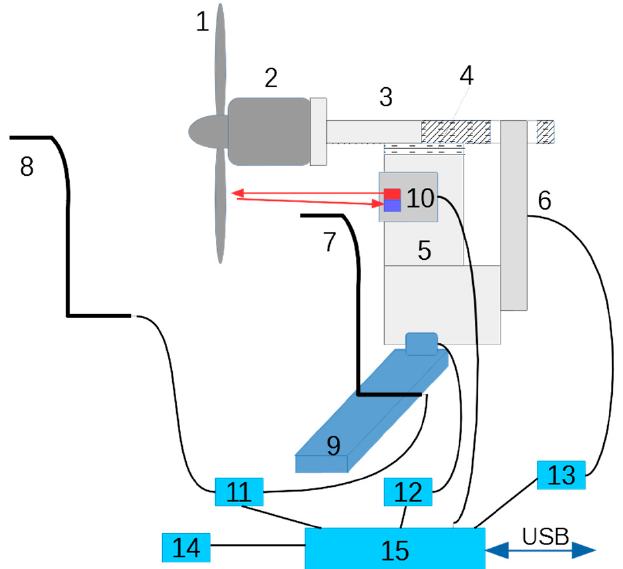
Figure 1. Experimental testing stand (1—propeller, 2—engine, 3—slider, 4—linear bearing, 5—base, 6—load cell, 7—Pitot tube, 8—reference Pitot tube, 9—motorized slider, 10—RPM, 11—pressure